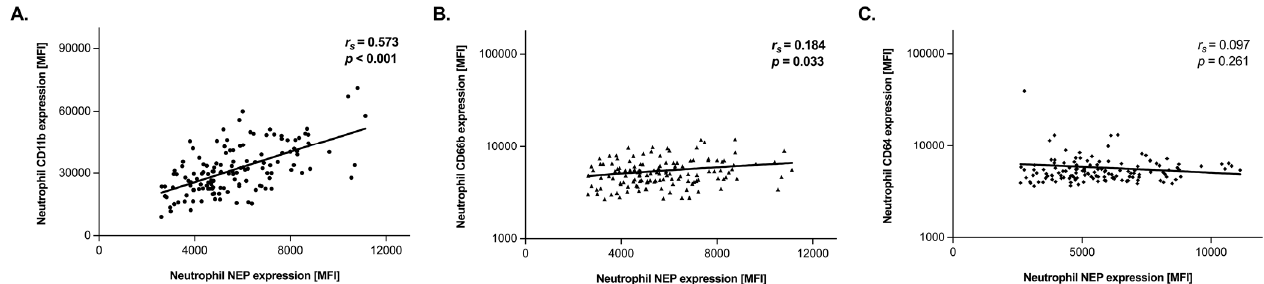
Figure 1. Relationship between neutrophil NEP expression and neutrophil activation/maturation markers CD11b ( A ), C66b ( B ) and CD64 ( C ). Scatter plot with linear regression analysis was performed and fit curves are shown. Spearman’s correlation coefficient and level of significance are indicated in the respective plots.